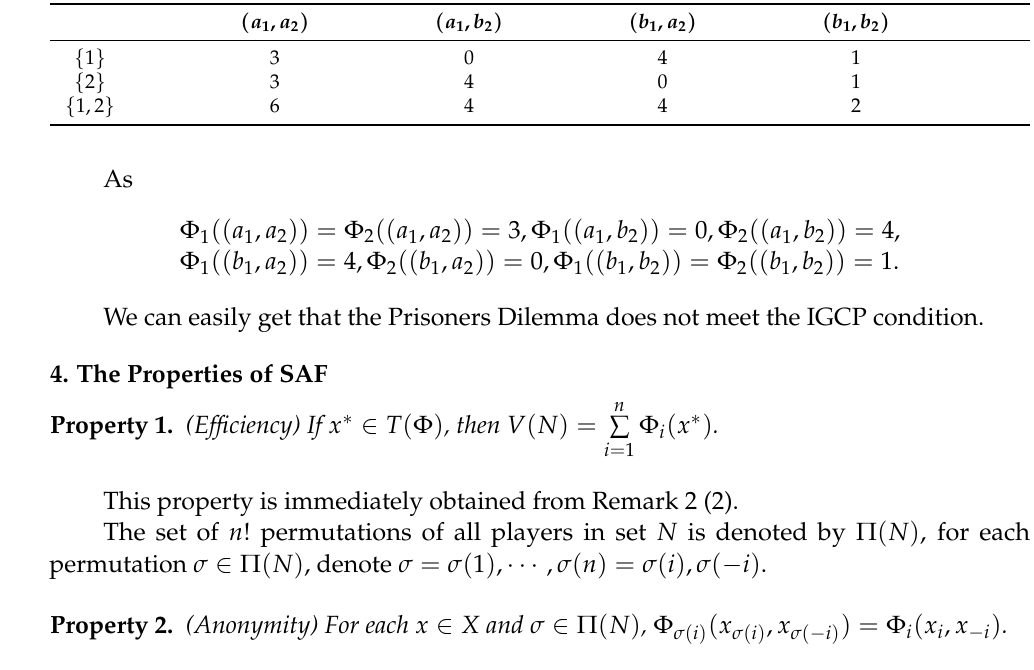
Table 4. A prisoners